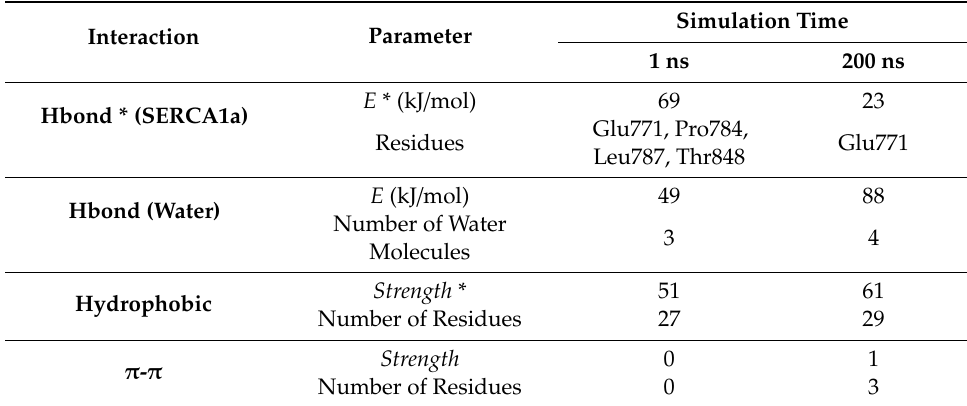
Table 3. Interaction parameters of the SERCA1a-RA complex with water at the beginning and after 200 ns MD